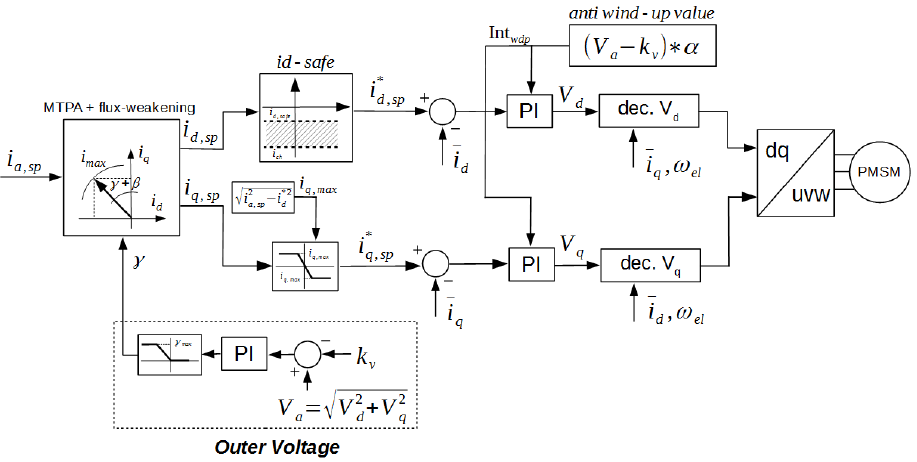
Figure 13. Control scheme of outer voltage method of [17] with the proposed i sd − safe strategy.